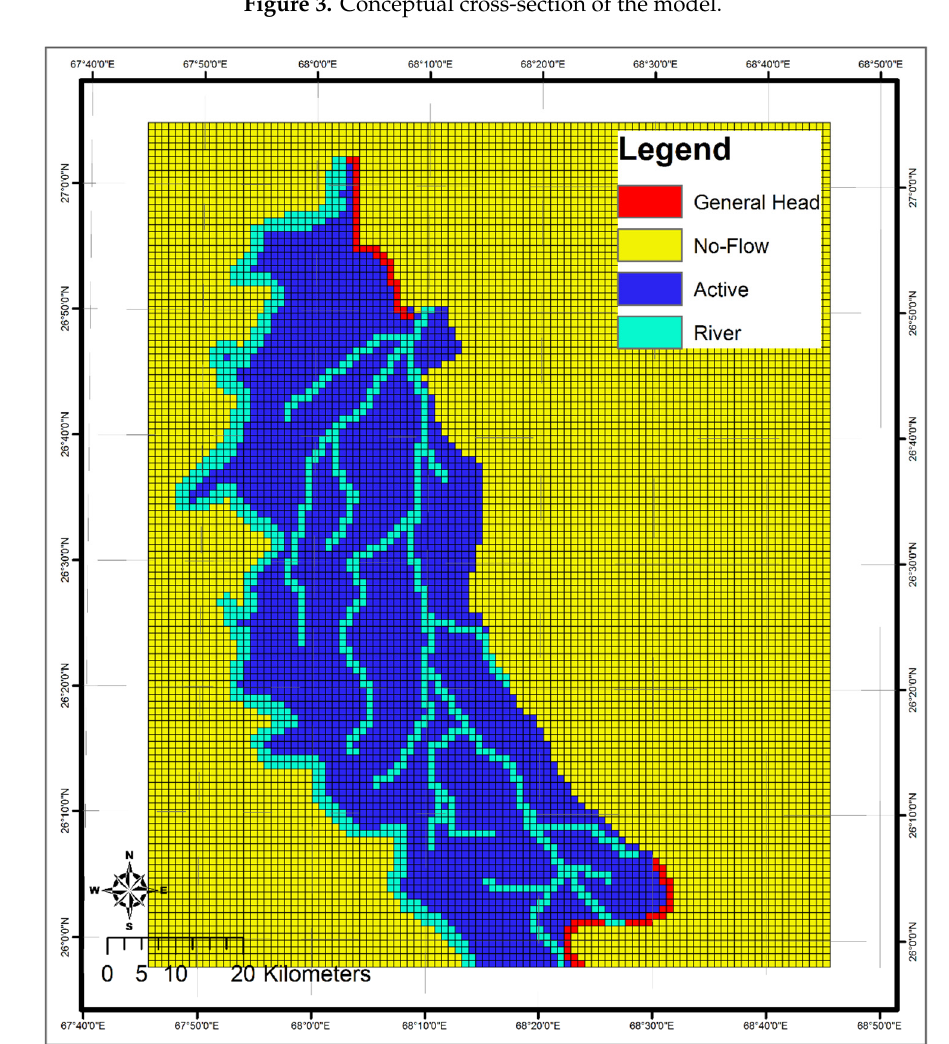
Figure 4. Discretization grid and boundary conditions of the groundwater model.